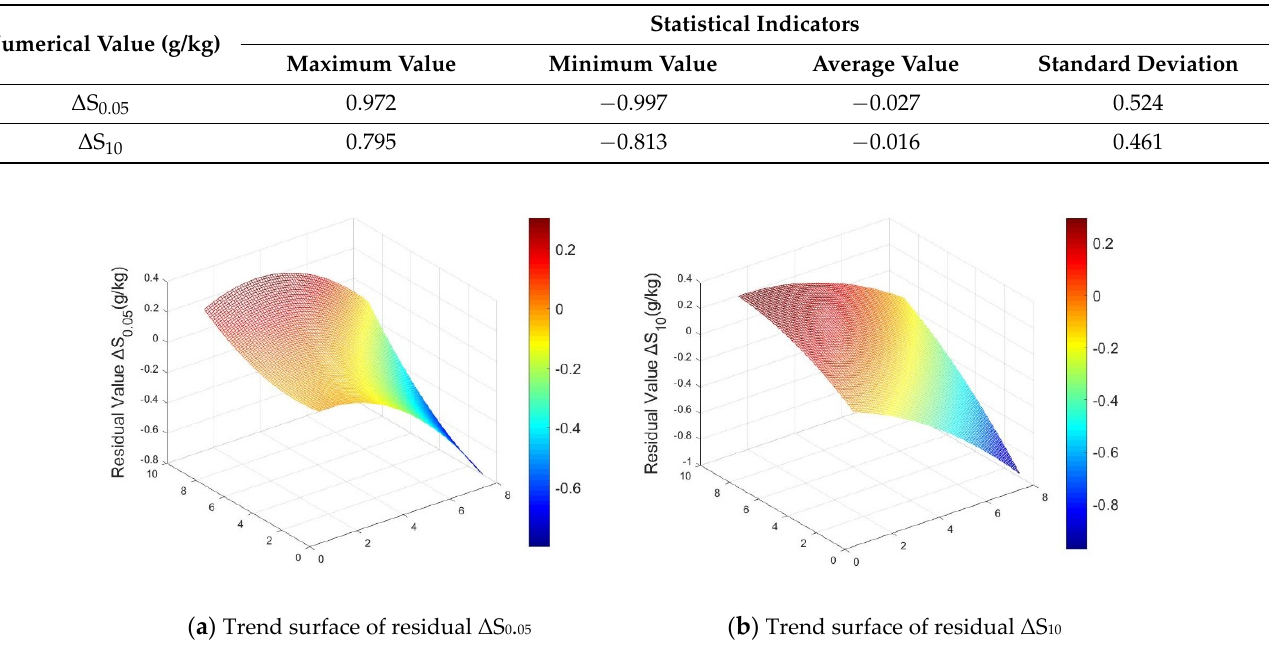
Figure 7. The trend surface of the residuals in the test area A.